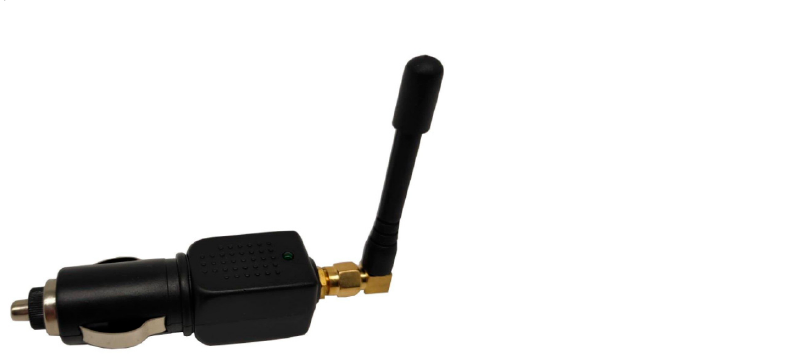
Figure 3. The basic GNSS jamming scheme of USVs: at some point in time, the jammer transmits white noise at GNSS frequencies, which aims to make a PVT solution impossible. All USVs in the jammed area lose orientation.